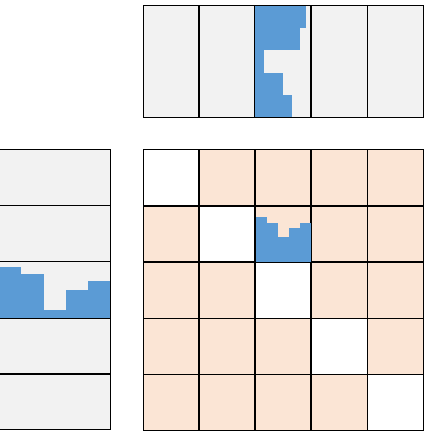
Figure 4. Representation of nodes and edges based on TimeCell.